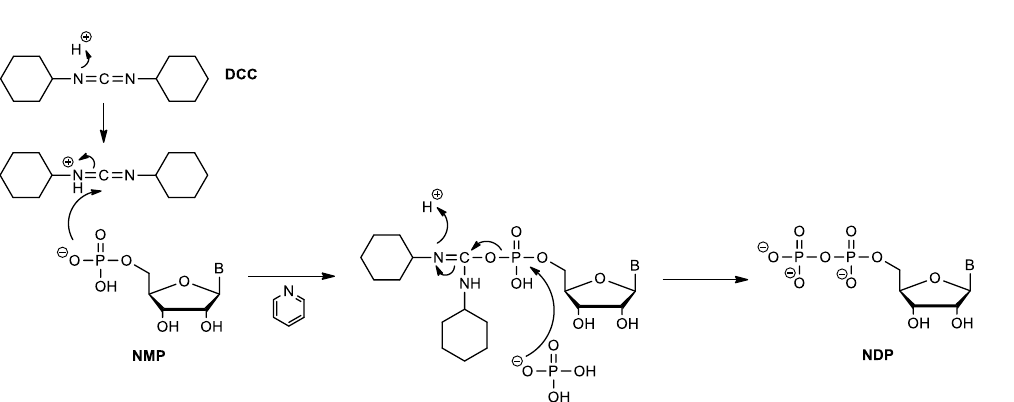
Scheme 4. A mechanism for the formation of nucleoside 5′ -diphosphates using dicyclohexylcarbodiimide (DCC) as a condensing agent.